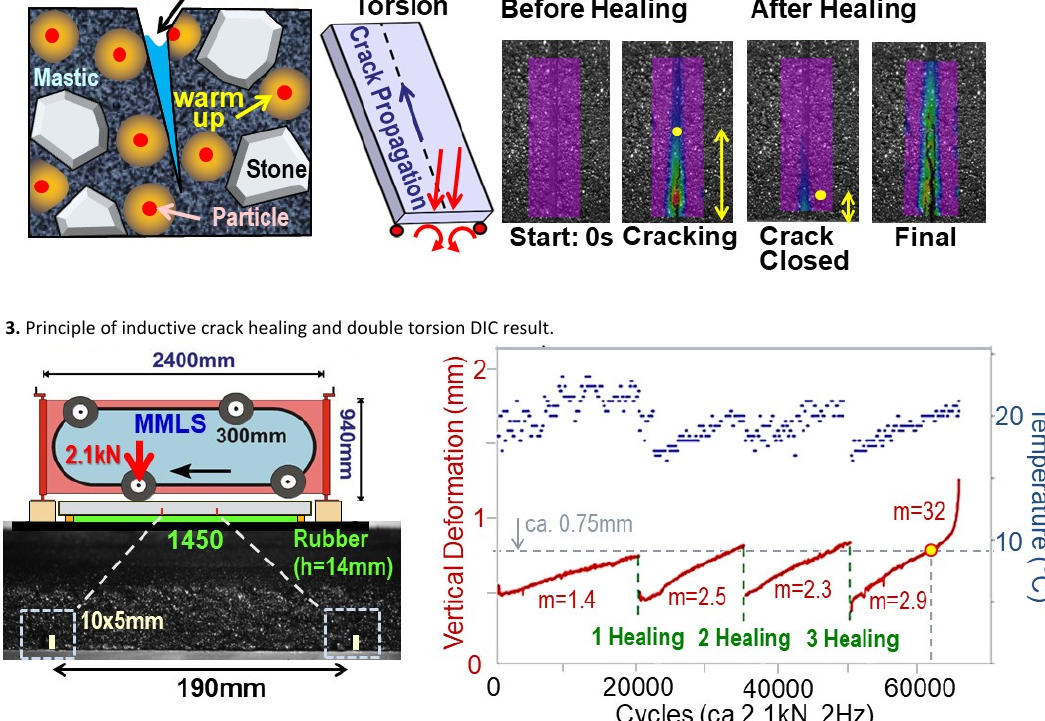
Figure 4. Vertical permanent deformation and slopes (m) due to MMLS loading before and after repeated inductive healing; also shown is the temperature